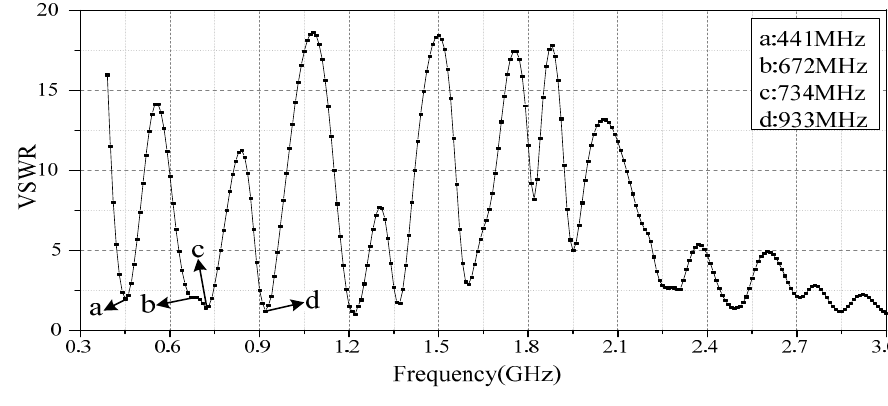
Figure 8. The simulated VSWR of the antenna.